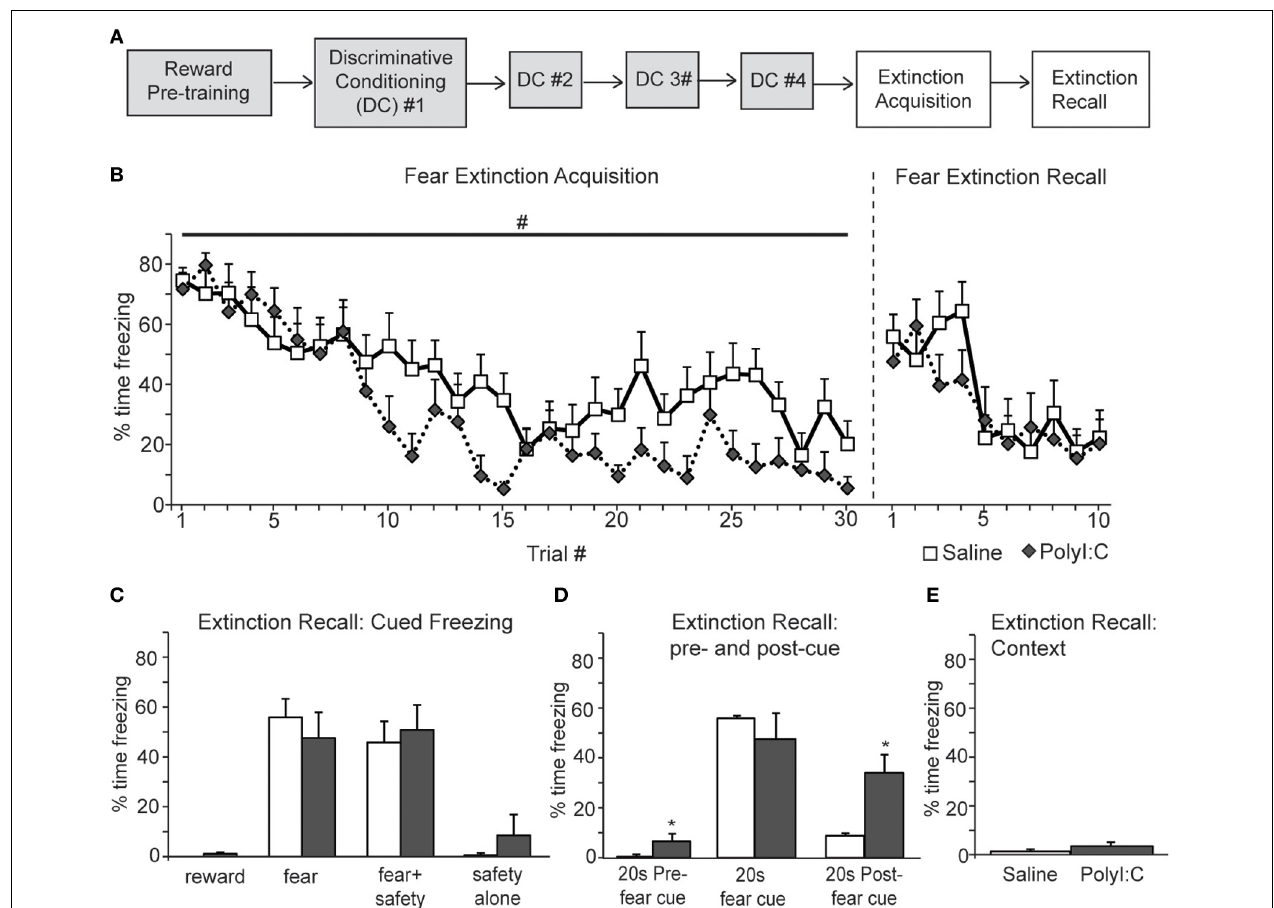
FIGURE 5 | A, Schematic of experimental design. Rats were pre-trained on the reward cue-reward pellet association followed by 4 Discriminative Conditioning sessions in which the reward cue ( + reward pellet), fear cue ( + footshock), fear + safety cues (no footshock) and safety cue (no footshock) were presented. During Extinction Acquisition all rats received unreinforced presentations of the fear and reward cues. Extinction Recall occurred the next day and consisted of unreinforced presentations of all cues. Data are presented below for the sessions indicated by white boxes. (B, left) Both groups demonstrated significant within session extinction of freezing behavior to the fear cue. Percent time freezing to each fear cue presentation is shown. Freezing to the last cue presentation was significantly lower